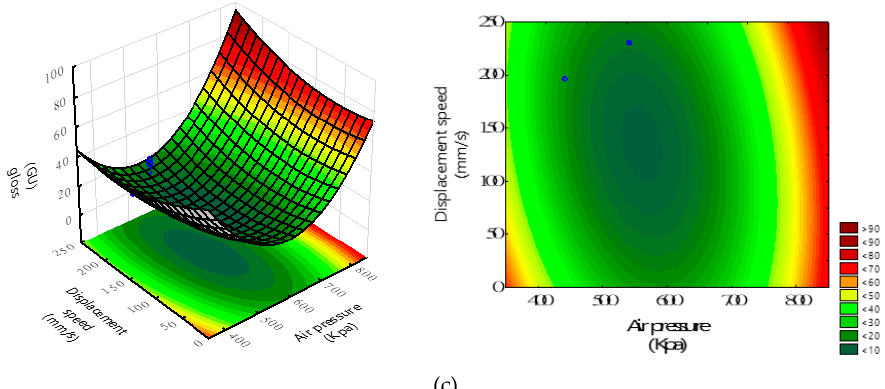
Figure 9. The response surface plots of gloss against the factors of ( a ) sol-gel deliver pressure (X 1 ) and air transport pressure (X 2 ) with X 3 of 140 mm/s; ( b ) displacement speed (X 3 ) and sol-gel deliver pressure (X 1 ) with X 2 of 560 kPa; and ( c ) displacement speed (X 3 ) and air transport pressure (X 2 ) with X 1 of 250 kPa. Table 6. The measured optimal condition of lowest gloss and highest haze, and the predicted ones from Equations (3) and (5), respectively.